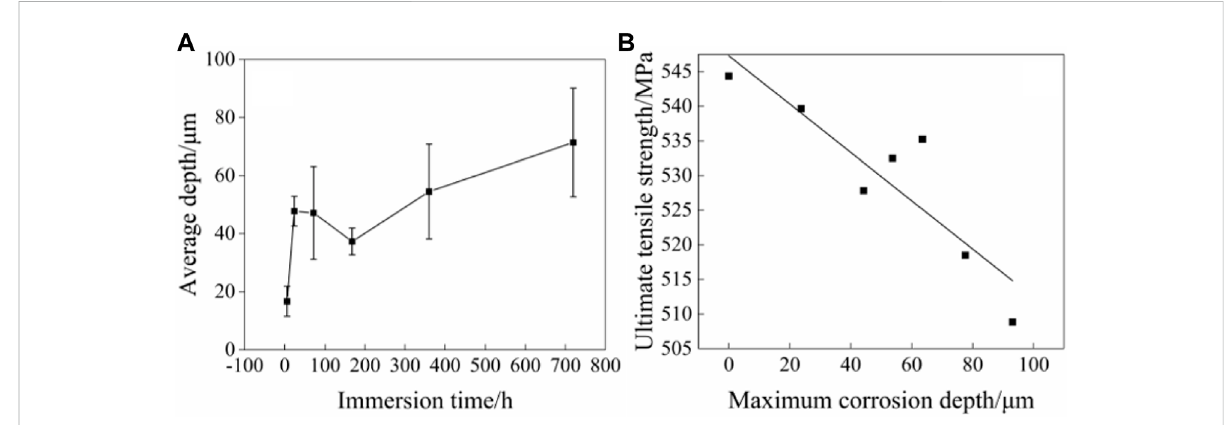
FIGURE 11 Correlation between corrosion depth and tensile strength of 2060-T6 Al-Li alloy immersed for 6, 24, 72, 168, 360 and 720 h in 3.5wt% NaCl solution. (A) Corrosion depth vs immersion time, (B) ultimate tensile strength vs corrosion